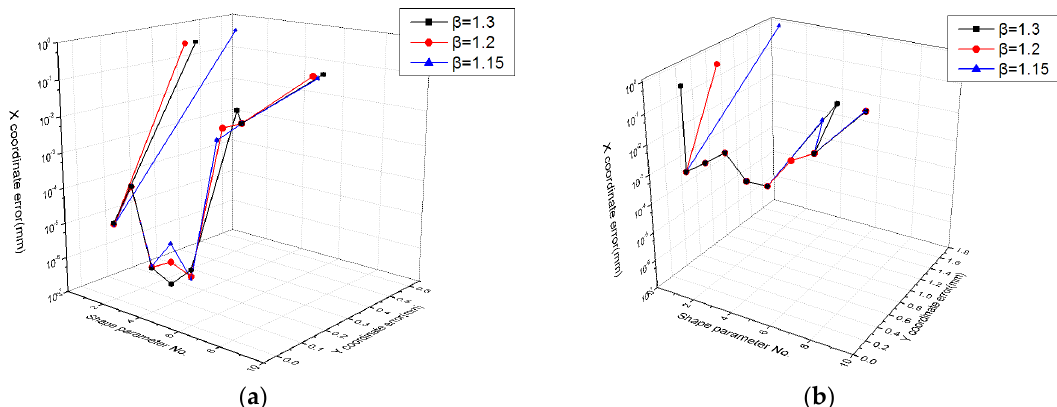
set. The y-axis uses a logarithmic scale. The y-axis uses a logarithmic scale.